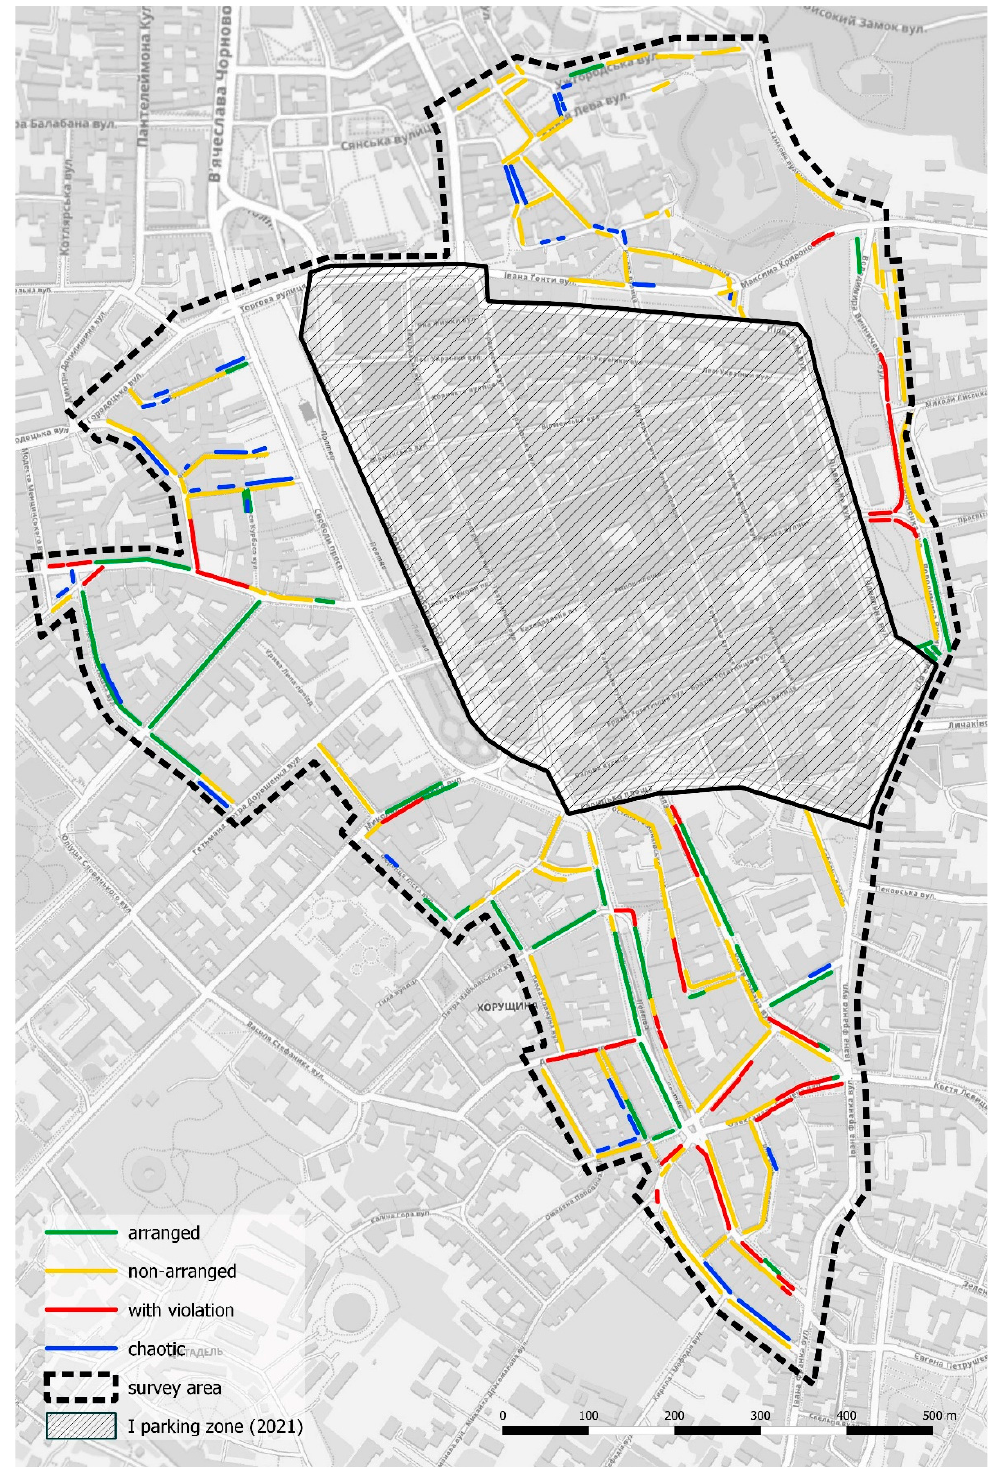
Figure 3. Scheme of on-street parking status in 2016 (“in situ”). Scheme by R. Liubytskyi. The parking zones in Lviv are conditional and do not have clear territorial bounda- ries within which all on-street parking is charged (as in Leipzig or Cracow). Much of the on-street parking spaces in the central part, as in the rest of the city, are free of charge and not regulated in any way, due to the lack of a ban on parking in places where no prohibi- tion signs are installed [58]. Zone II, in 2016, was the territory outside zone I, which for- mally covered the entire city, but in fact it regulated only the price of individual on-street